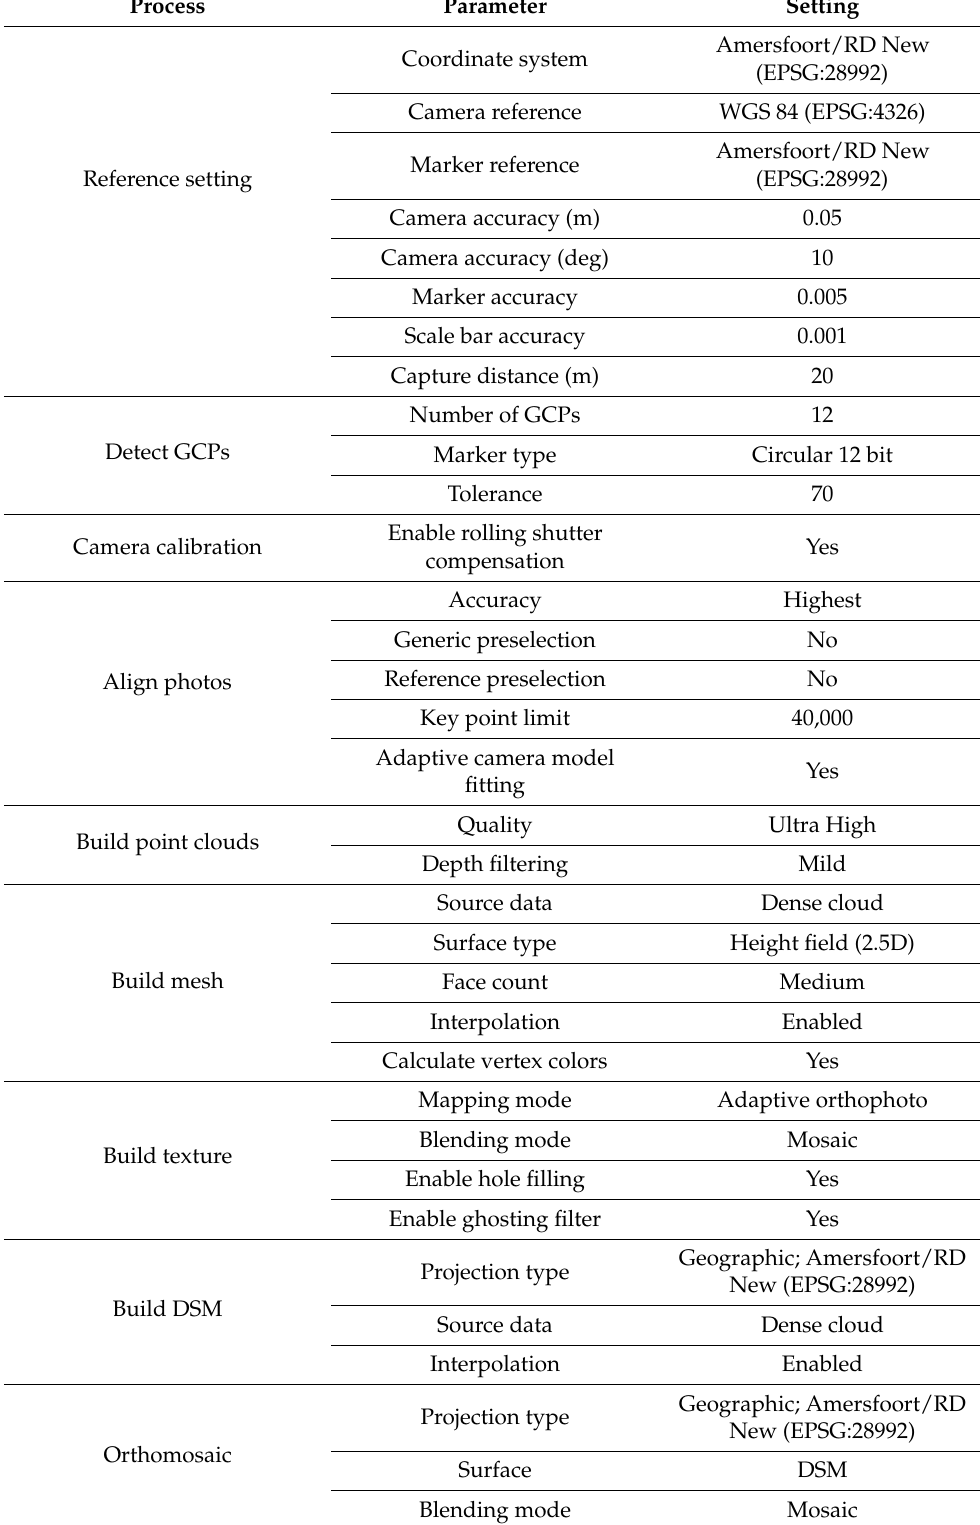
Table 2. Parameters for UAV image processing by Agisoft Metashape